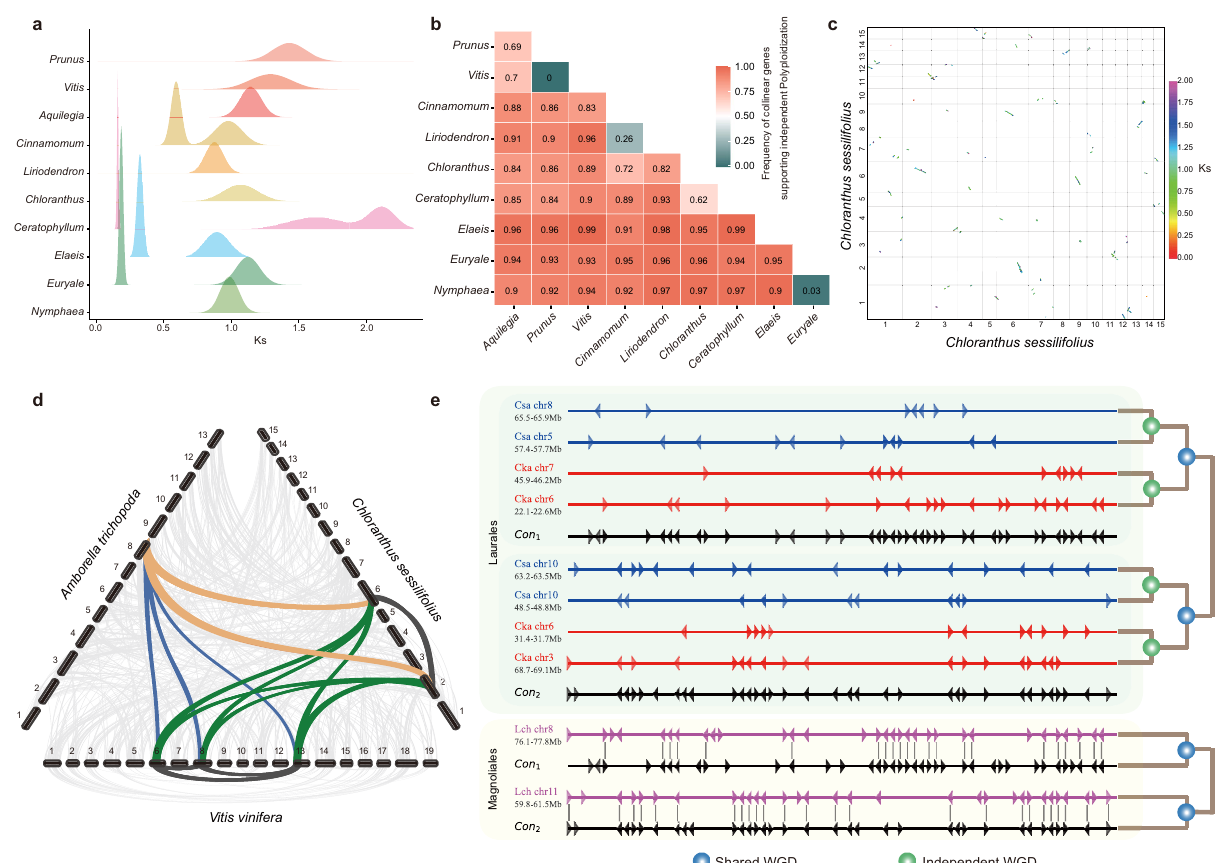
Fig. 2 Comparative genomics analyses. a The Ks distributions of intragenomic synteny blocks. b The proportion of collinear gene trees that support the independent polyploidization between each species-pair. c Synteny blocks of the C. sessilifolius genome. d Synteny patterns between genomic regions from C. sessilifolius , A. trichopoda , and V. vinifera . e Local alignment of Magnoliales ( Liriodendron -Lch) and Laurales ( Cinnamomum -Cka and Chimonanthus -Csa). The graph shows details of a short segment of alignment, and the names behind the species are the chromosome numbers. The location and direction of genes are shown by a triangle. Reconstructed putative ancestral chromosome segments of Laurales, named as Con1 and Con2, are displayed accordingly. Homologous genes between neighboring chromosomal regions are linked with lines. Source data are provided as a Source Data fi